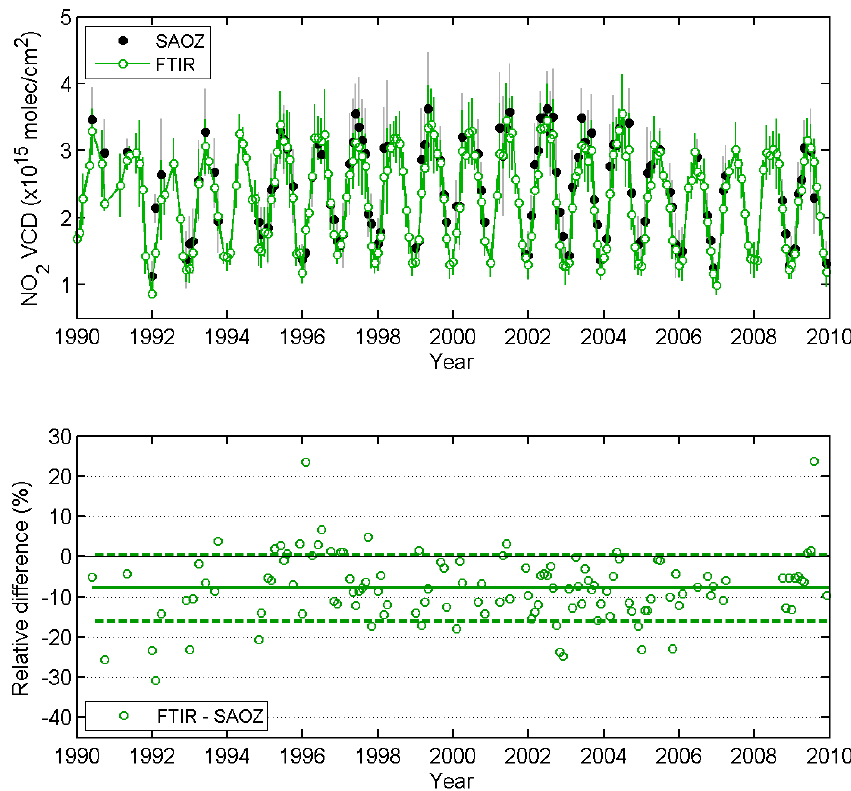
Fig. 2. Comparison between FTIR and SAOZ monthly mean stratospheric NO 2 columns at Jungfraujoch (46.5 ◦ N, 8 ◦ E) for the 1990–2009 period. The error bars correspond to the 1-sigma standard deviation (natural variability). The relative differences appear on the lower plot with solid and dashed green lines corresponding to the mean FTIR – SAOZ difference and its 1-sigma standard deviation, respectively, which is − 7.8 ± 8.2%.